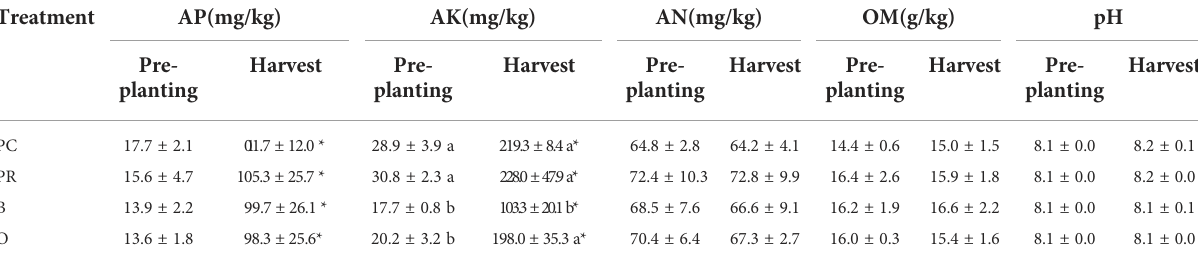
TABLE 1 Soil chemical properties at pre-planting and harvest in different cropping systems in 2021.